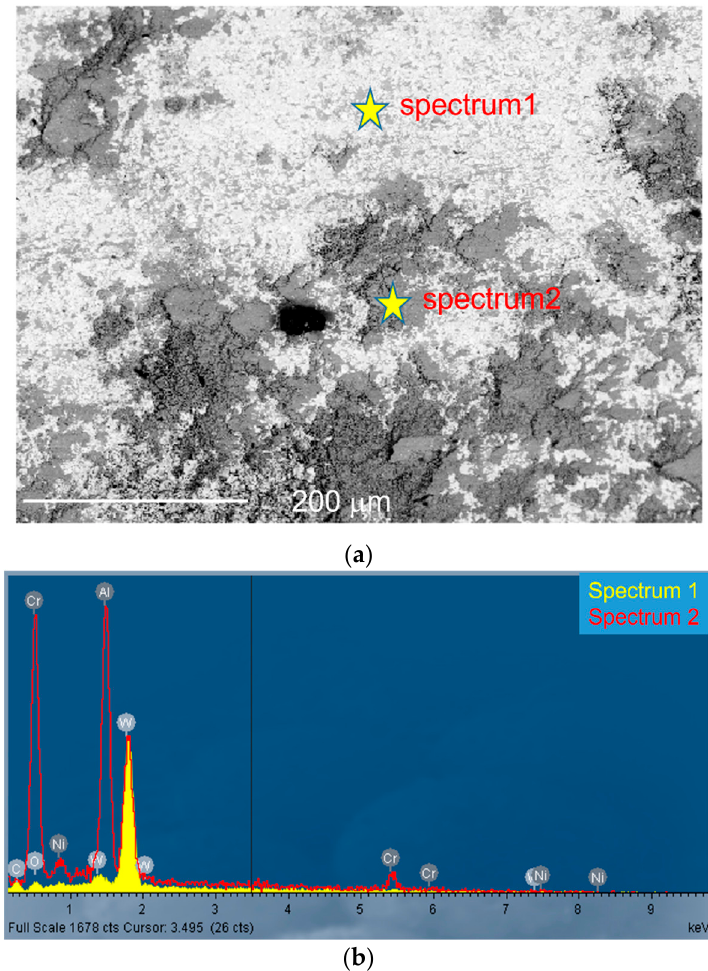
Figure 15. SEM micrograph ( a ) and EDS analysis ( b ) of WC-Cr 3 C 2 -Ni.